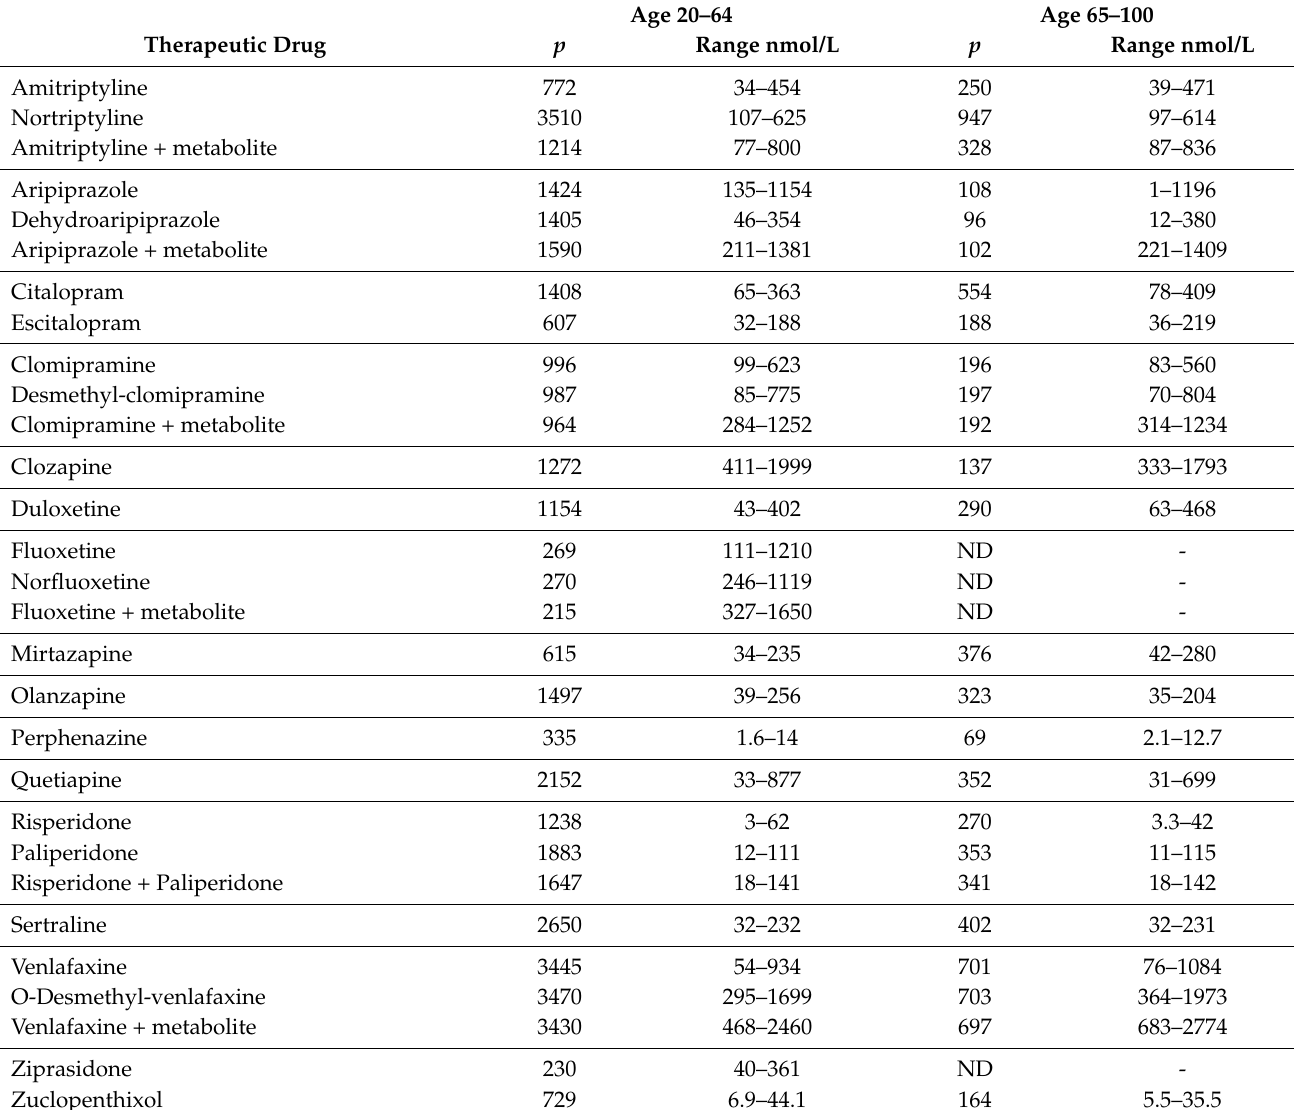
Table 5. Examination of the influence of age on the calculated 10–90 percentile therapeutic analytical range. Ranges of 20–64 and 65–100 years were calculated with the RefIT software by using the data set from Aarhus University Hospital. Here, p indicates the number of patients included in the data set of each compound. ND—no data; <100 samples. For additional statistics, see Supplementary Data File Table